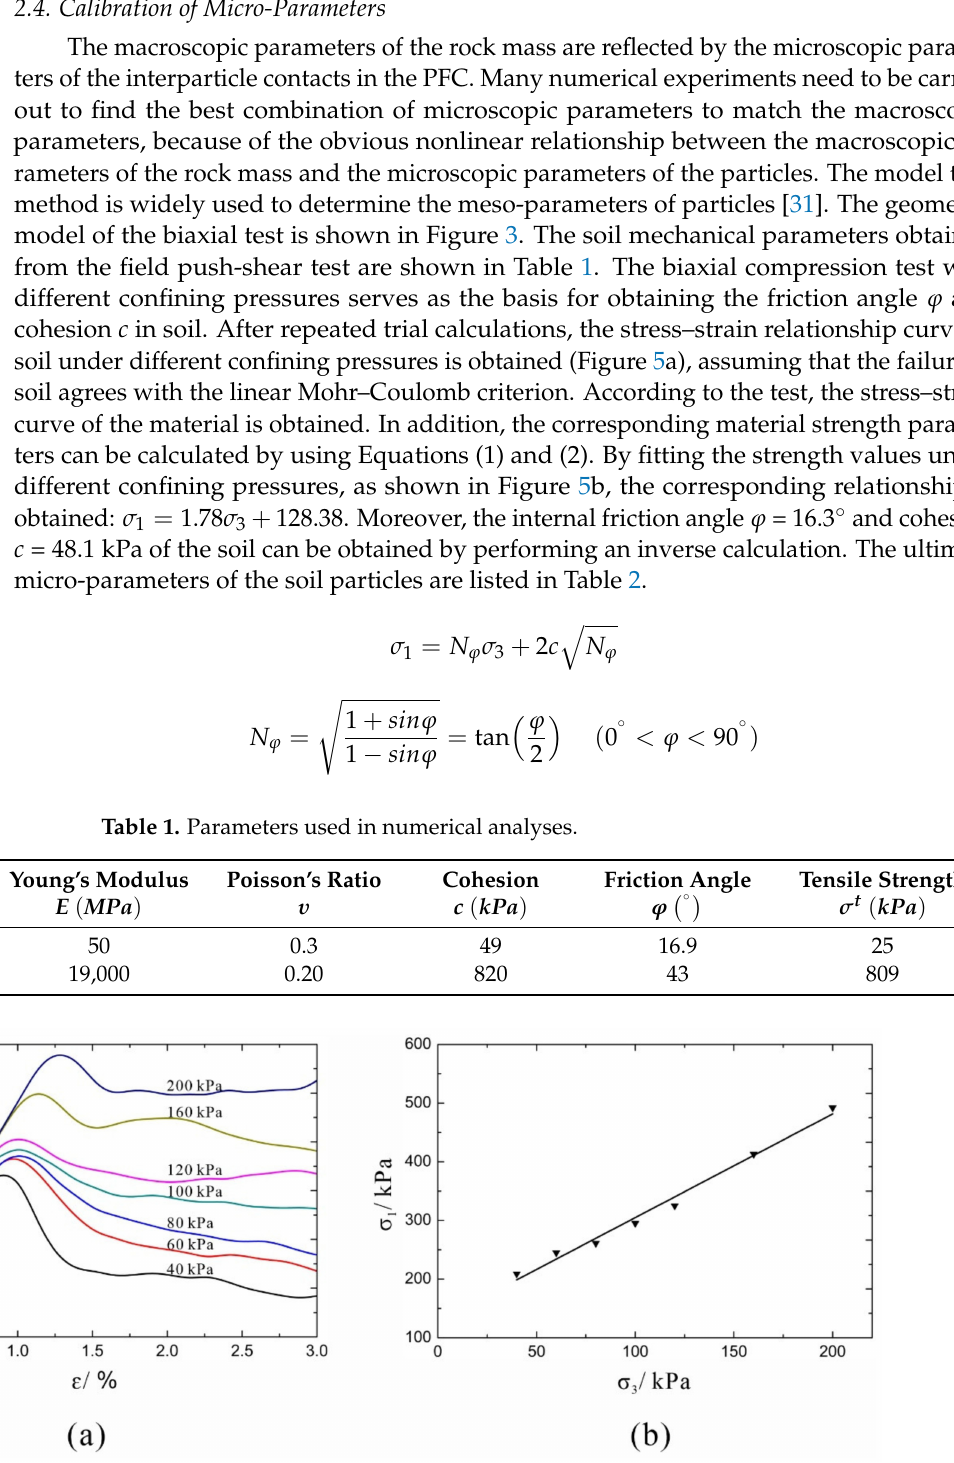
Figure 5. The calibration process of the micro-parameters through biaxial compressive experiments: ( a ) Stress–strain curve of the soil model under different confining pressures. ( b ) Correlation between two principal stresses of the soil